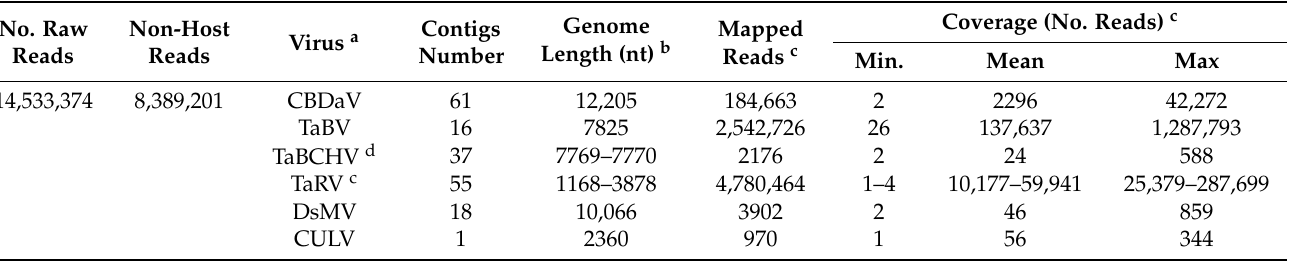
Table 1. Number of high-throughput sequencing (HTS) reads, contigs, and depth of coverage values for each virus found in ABVC-symptomatic taro plants from Papua New Guinea.